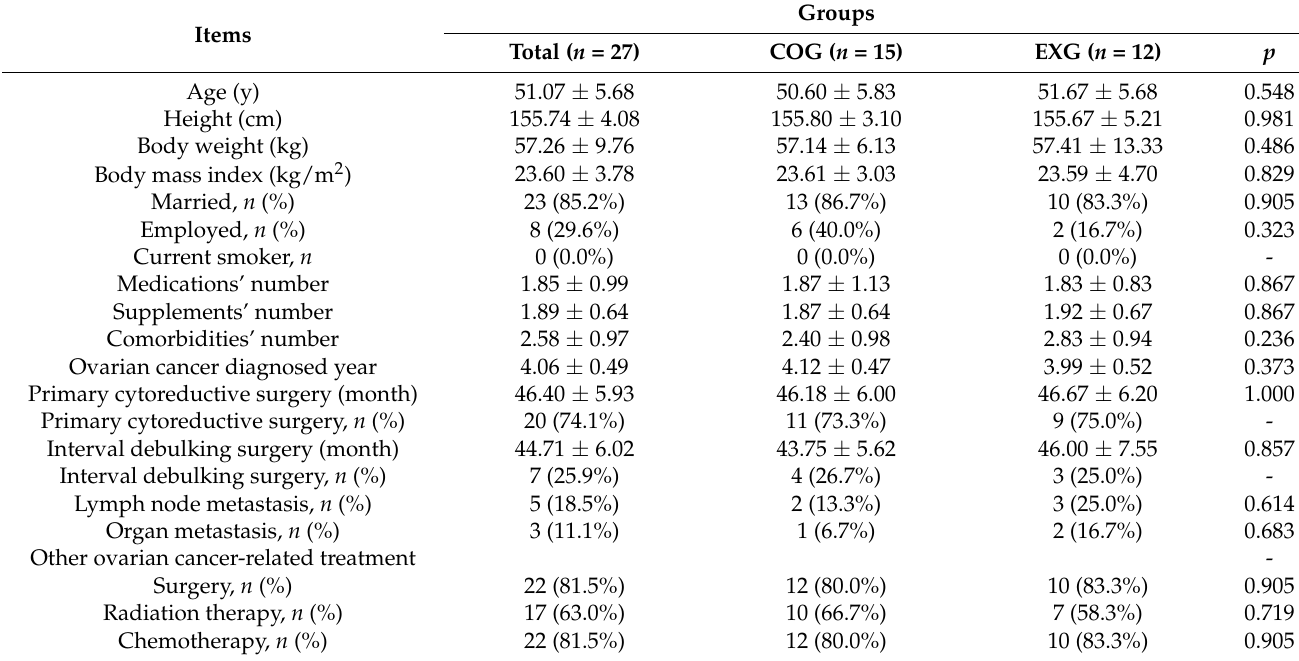
Table 2. Demographic and clinical characteristics of the ovarian cancer